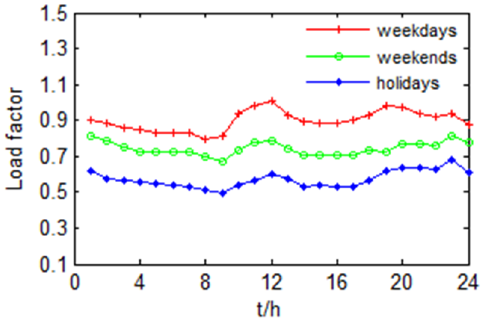
Figure 1. Timing characteristics of loads under different date